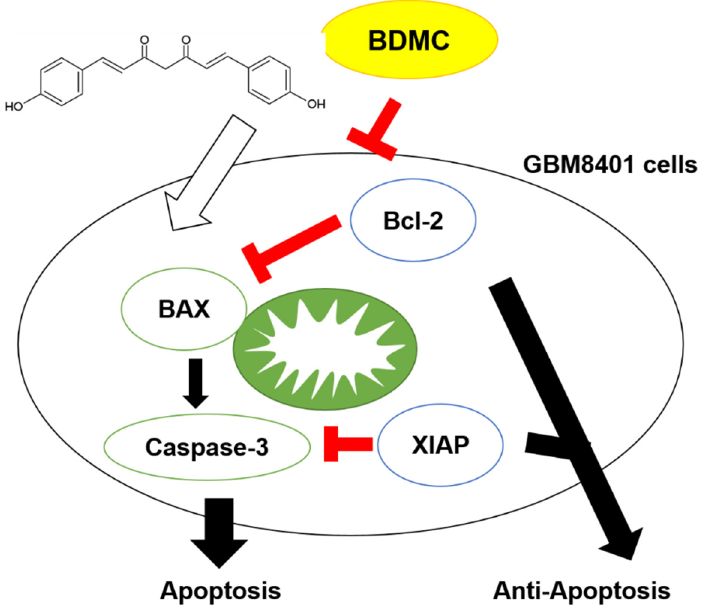
Figure 7. The mechanisms involved in inhibiting tumor growth upon BDMC treatment.